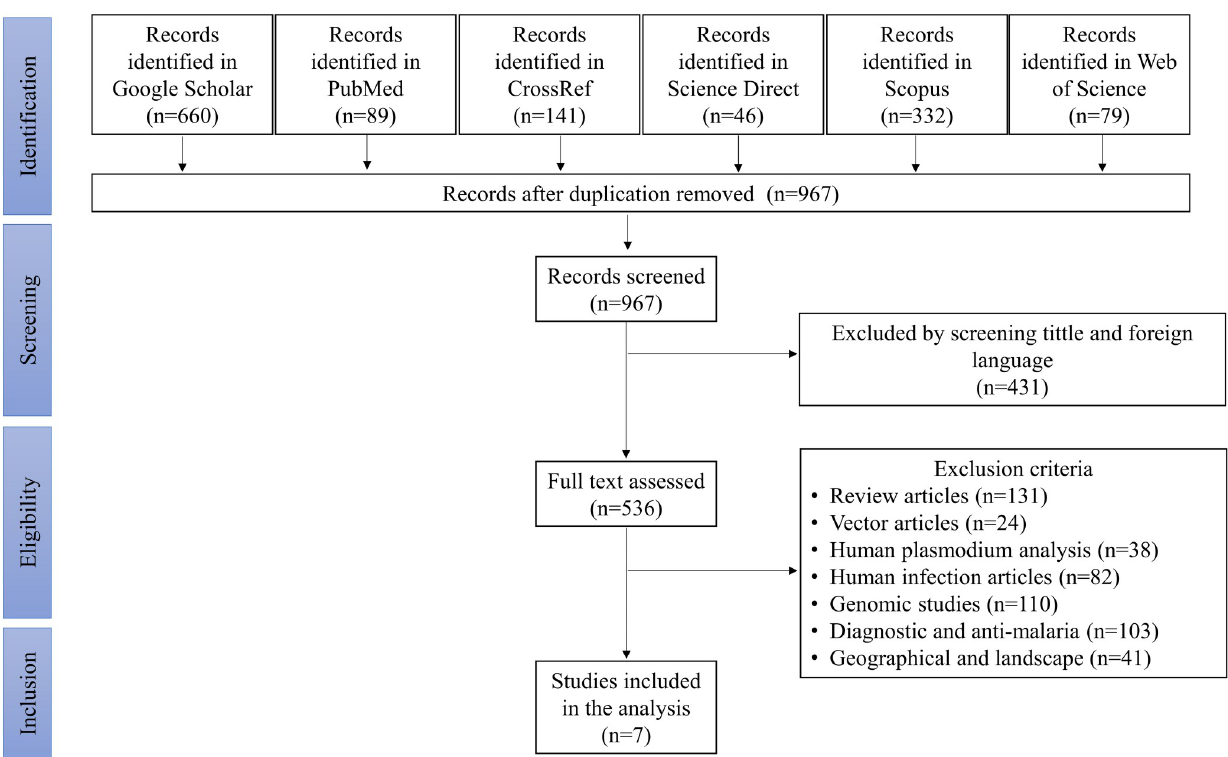
Fig 1. Flowchart of selected articles for the systematic review following the PRISM guidelines.